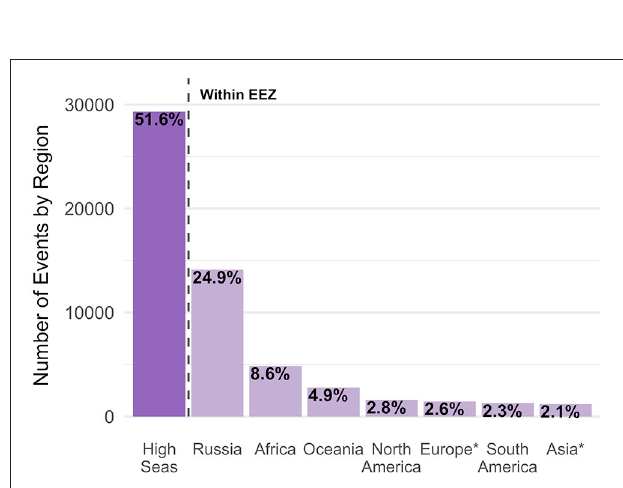
FIGURE 2 | Global patterns of transshipment behavior illustrating encounters (red) and loitering events (black). Highest densities appear in the Russian Far East and the Barents Sea, outside the Exclusive Economic Zones (EEZs) of South America, within the EEZs of African nations, and across the Equatorial Pacific.